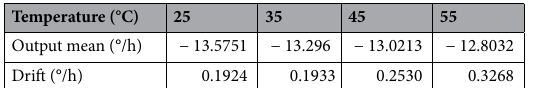
Table 1. Gyro output parameters under constant